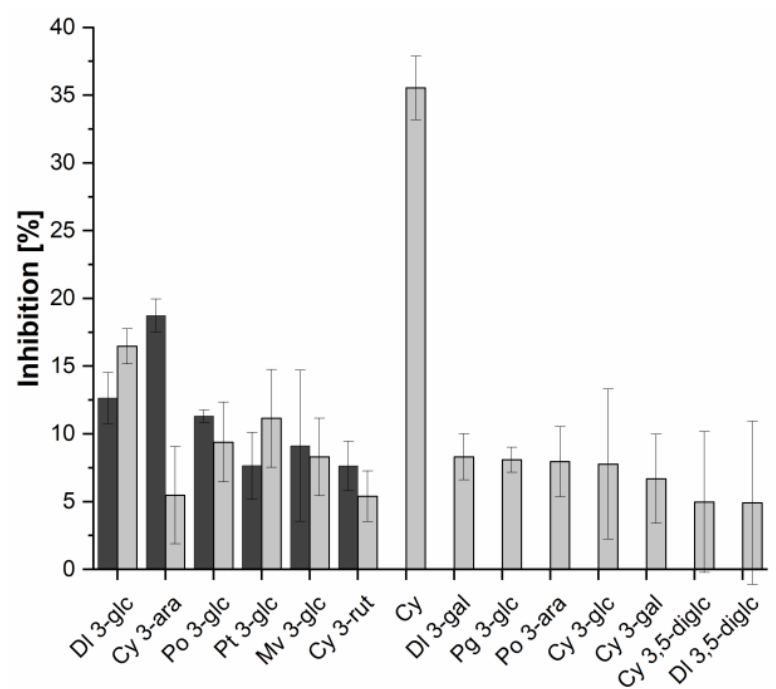
Figure 4. Inhibition (%) of α -amylase (dark grey) and α -glucosidase (light grey) assay. Results are shown for anthocyanin standards. Bars represent means ± SD ( n = 3). Cy = Cyanidin, Mv = Malvidin, Pt = Petunidin, Po = Peonidin, Dl = Delphinidin, Pg = Pelargonidin, rut = rutinoside, glc = glucoside, ara = arabinoside, diglc = diglucoside, gal = galactoside.